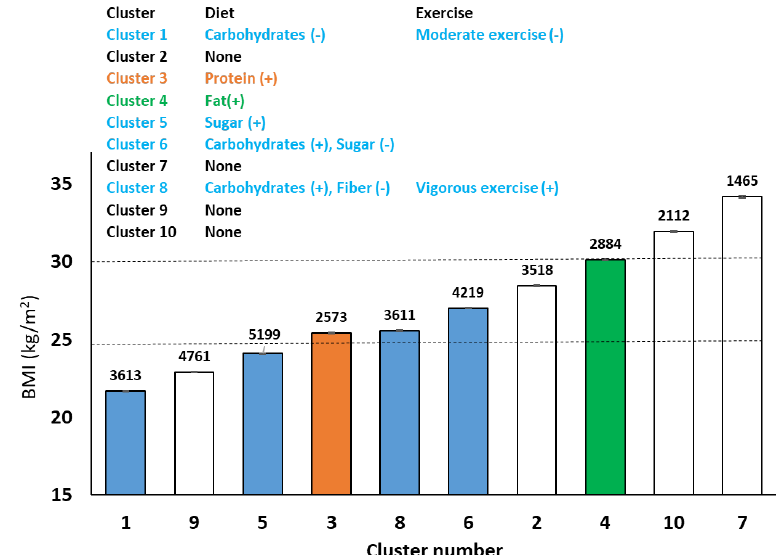
Figure 5. Clusters and their BMI classes, along with the number in each cluster. The inset table shows that stepwise multiple regression analysis identified the strongest predictors of body weight (kg) based on macronutrient and exercise subcomponents. Positive and negative signs indicate the directionality of